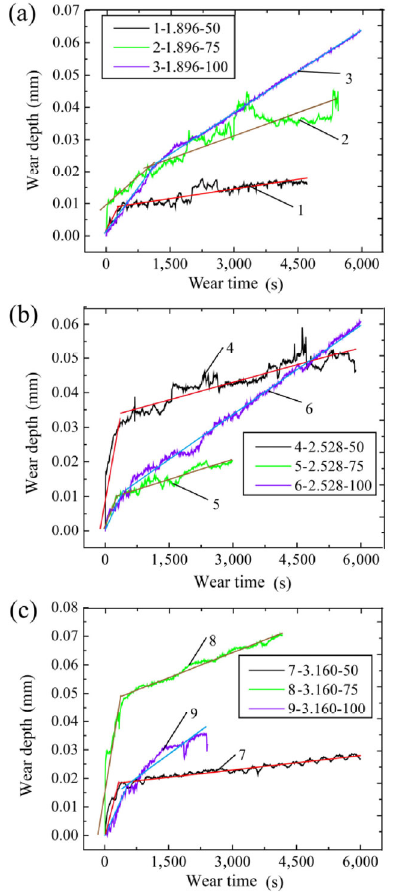
Fig. 1 Physical diagram and schematic diagram of wear test of fabric liners: (a) photograph of the friction and wear tester, and (b) schematic diagram of pin-on-plate reciprocating sliding wear test.